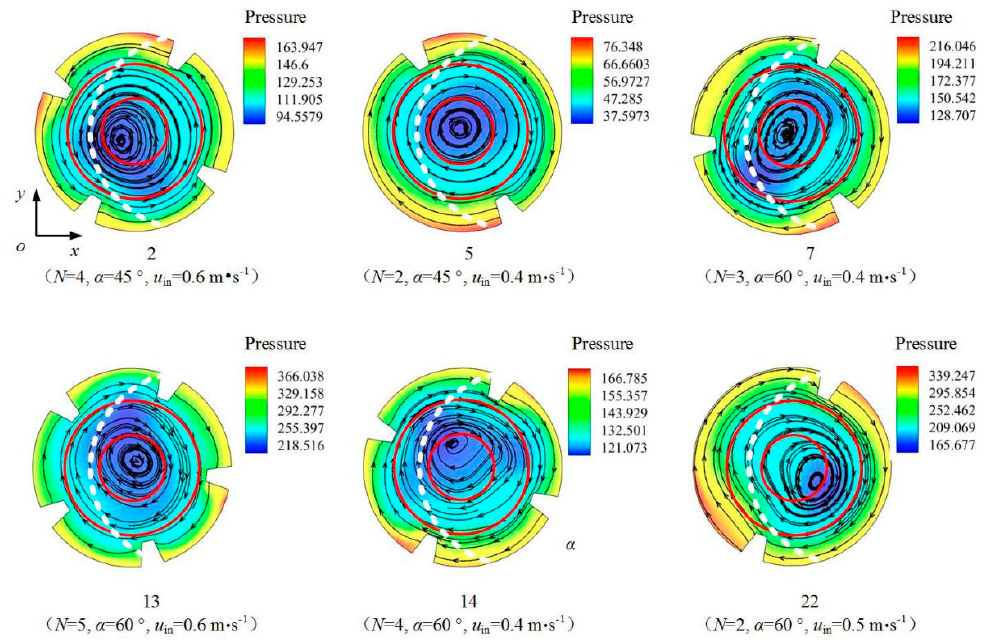
Figure 10. Pressure distributions and L/D boundaries (single-sided illumination) on the z = 2.5 m cross section of the PBR in tests 2, 5, 7, 13, 14, and 22.